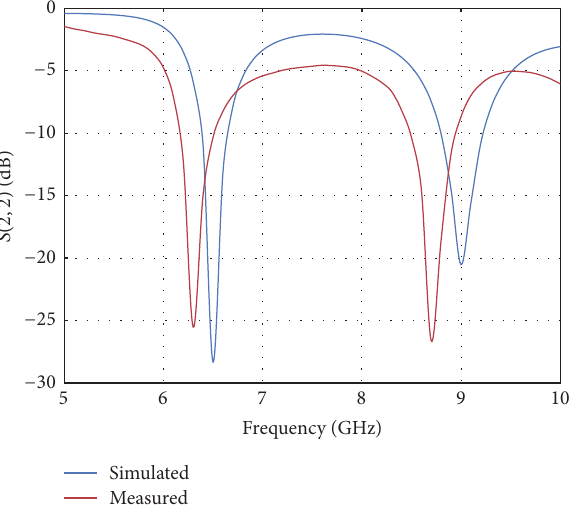
Figure 14: 2D radiation pattern of the UWB antenna at 9.75 GHz. Figure 15: Comparison of simulated and measured reflection coefficients of the first NB